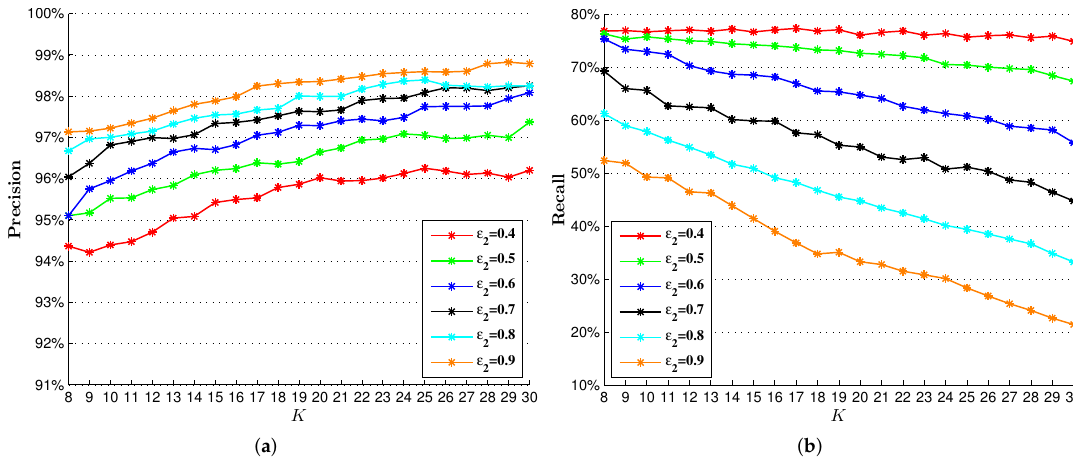
Figure 8. The effects of the number of nearest neighbors K and the slope threshold ε 2 are used to rectify the mismatched pairs. ( a ) The average precision of SRR with different K and ε 2 . ( b ) The average recall of SRR with different K and ε 2 .